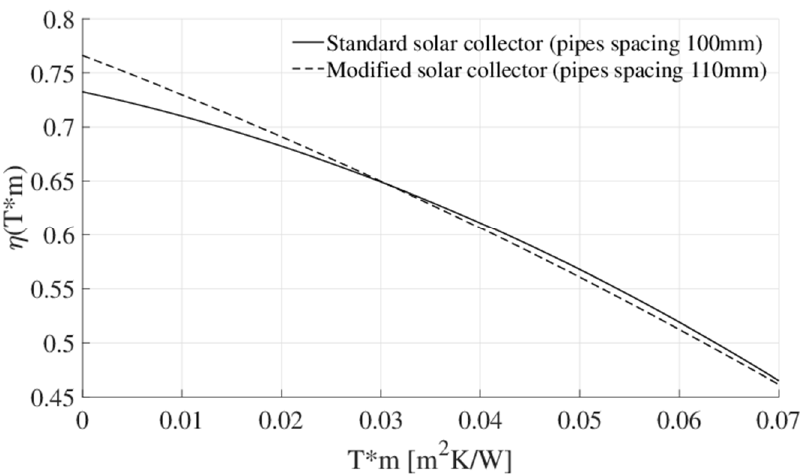
Figure 11. Comparison between the efficiency curves (cid:2015)((cid:1846) ∗ (cid:1865)) of a standard collector and a modified collector with an increased spacing between working pipes. collector with an increased spacing between working